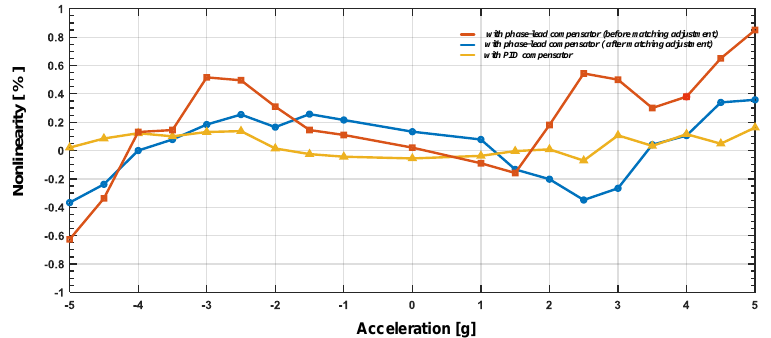
Figure 17. The nonlinearity test result of the EM- Σ∆